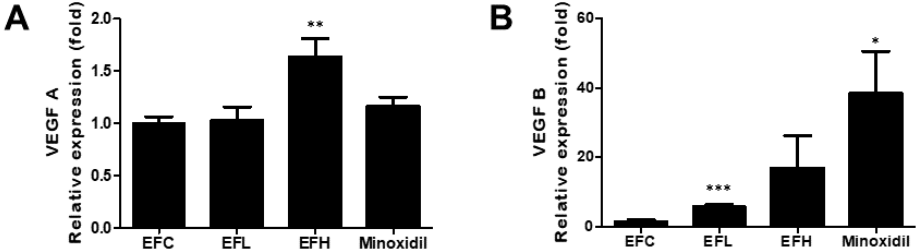
Figure 6. The effect of EF-2001 on the mRNA expression of hair-growth-related genes ( A ) VEGF-A and ( B ) VEGF-B in C57BL/6 male mice. Quantitative PCR analysis of the mRNA expression of VEGF-A and VEGF-B in the EFC-, EFL-, EFH-, and minoxidil-treated groups. * p < 0.05, ** p < 0.01, *** p < 0.001 versus EFC. Data are expressed as mean ± SD ( n = 5).